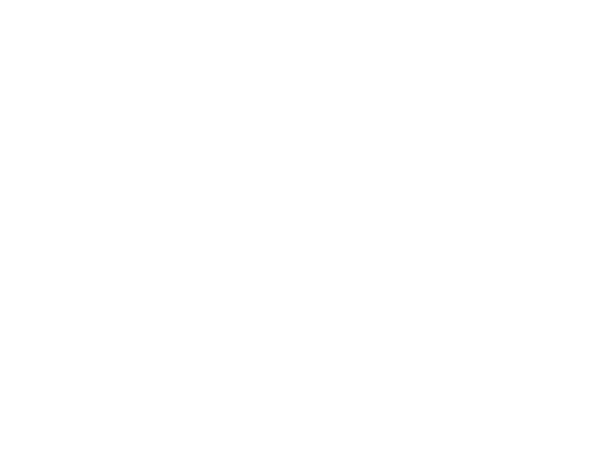
5 of 11 Figure 2. Sketch of the polarization of the light beam after the PEM, for an applied voltage value such that the phase shift is Δ 𝜑 = π /2. The red curve represents (vs. time) the voltage driving the PEM at the frequency ν 0 . At V = 0 volt, the polarization is linear, here directed as α (yellow arrows). When the voltage reaches its maximum, the resulting polarization is circular and right handed (green circles). When the voltage reaches its minimum, the resulting polarization is circular and left handed (blue circles). The oscillation frequency of the signal between the two states of circular polarization is evidently ν 0 . The frequency of the linearly polarized signal is 2 ν 0 . The technical equipment for the CD-RAS experiments is sketched in Figure 3. After being transmitted through the sample, the beam is reflected on an oxidized Si(100), perfectly isotropic for linearly polarized light, not introducing any artifacts in the signal.